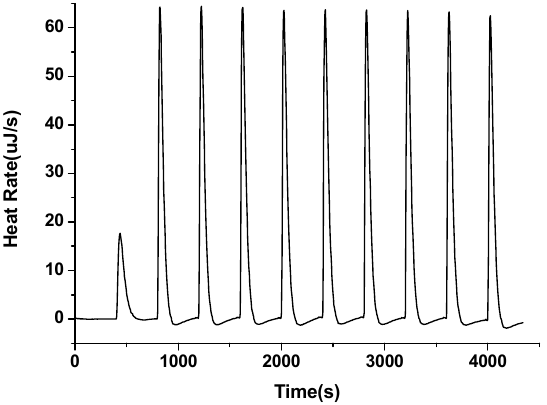
Figure 3. ITC (Isothermal titration calorimetry) for determining the heat of the reaction between Ac-tempo + ClO 4 − and BH 4 (R = CH 3 ) in acetonitrile at 298 K. Titration was conducted by adding 10 μ L of Ac-tempo + ClO 4 − (1.1 mM) every 400 s into the acetonitrile containing the BH 4 (R=CH 3 ) (10 mM). Basedontheelectrochemicaldata E 1/2 (H +/0 )= − 2.307(Vvs. Fc +/0 )and E 1/2 (H 0/ − ) = − 1.137 (V vs. Fc +/0 ) and ∆ H (Ac-tempo + ), we substituted the thermodynamic data (directly mea- sured) into Equations (4)–(7) to obtain the hydride affinity ∆ H H - A (X) and hydrogen-atom affinity ∆ H HA (X) of unsaturated carbonyl compounds as well as the hydrogen–atom affin- ity ∆ H HA (X •− ) and proton affinity ∆ H PA (X •− ) of the corresponding radical anions. All the data are summarized in Table 2. Table 2. Hydride and Hydrogen Affinities of Unsaturated Ketones (A, B) and Saturated Ketones (BH 2 ), Hydrogen and Proton Affinities of X •− in